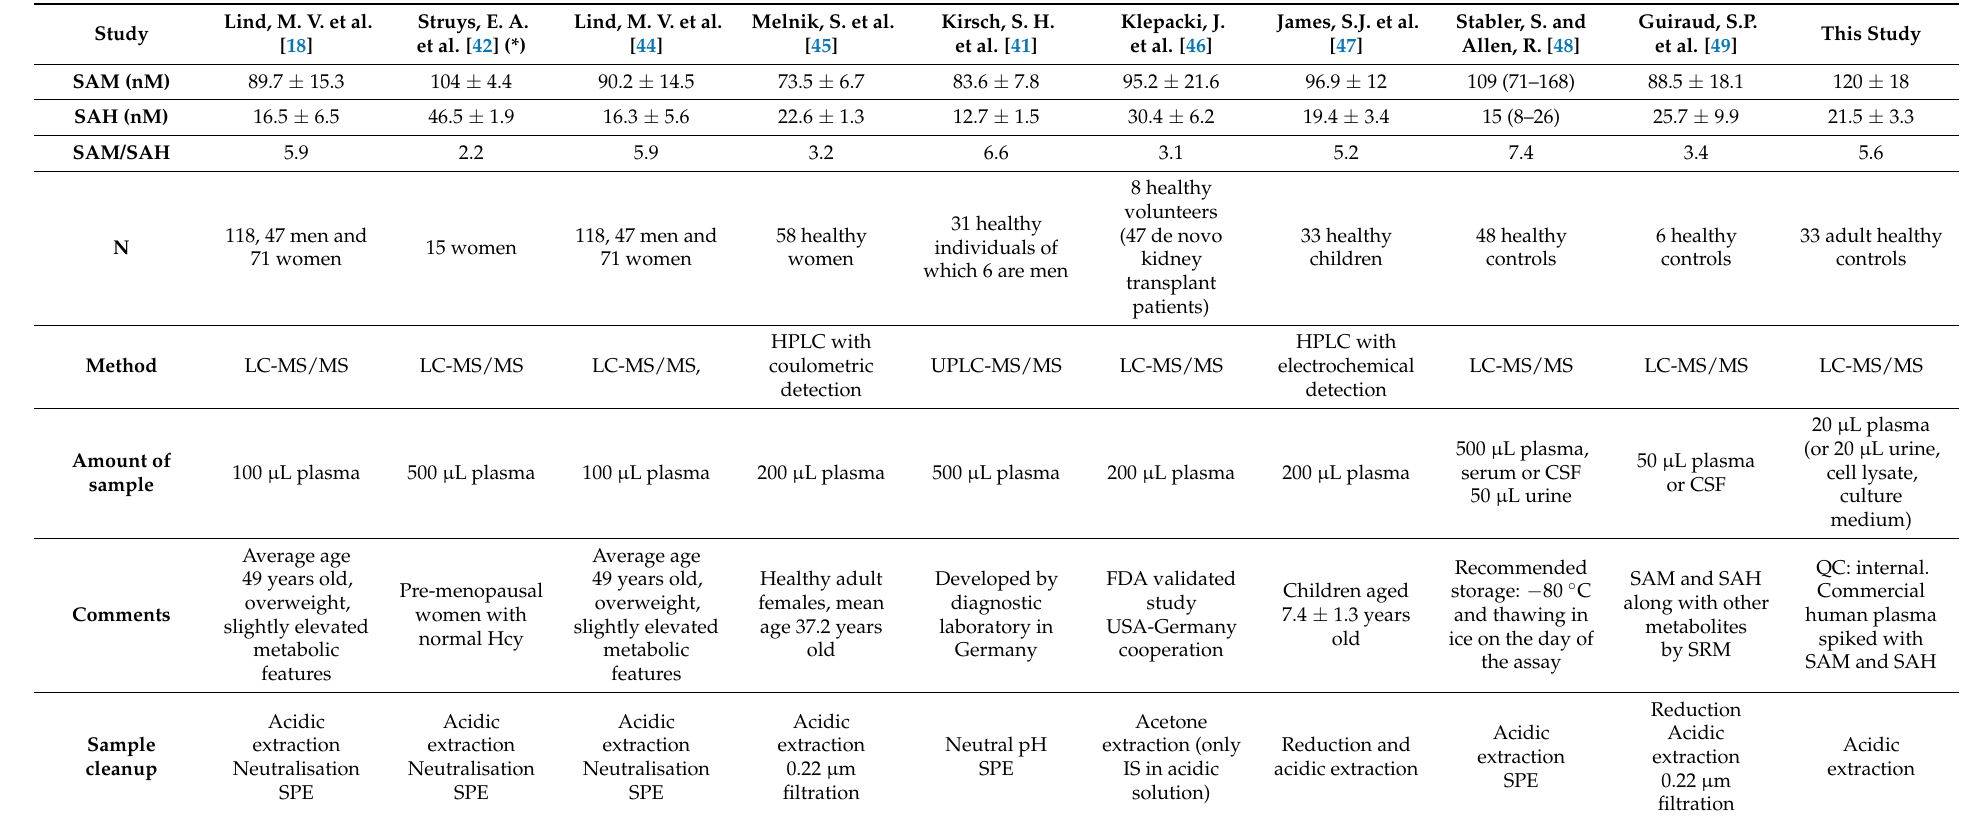
Table 4. Review of published SAM and SAH concentrations in human